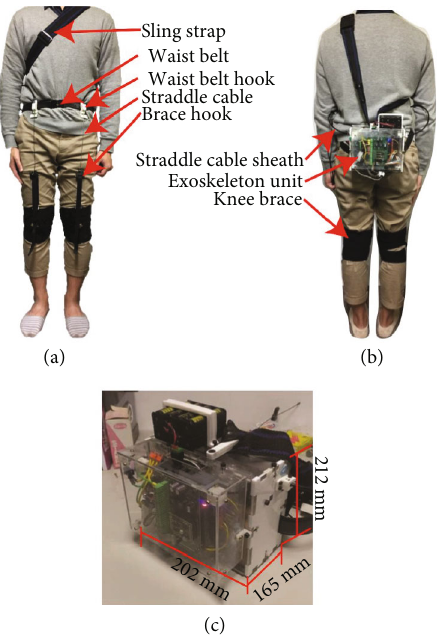
Figure 2: (a) Front and (b) back views of the wearable soft exoskeleton. (c) Exoskeleton system comprising a start button, an actuation unit, sensors, a controller, and a